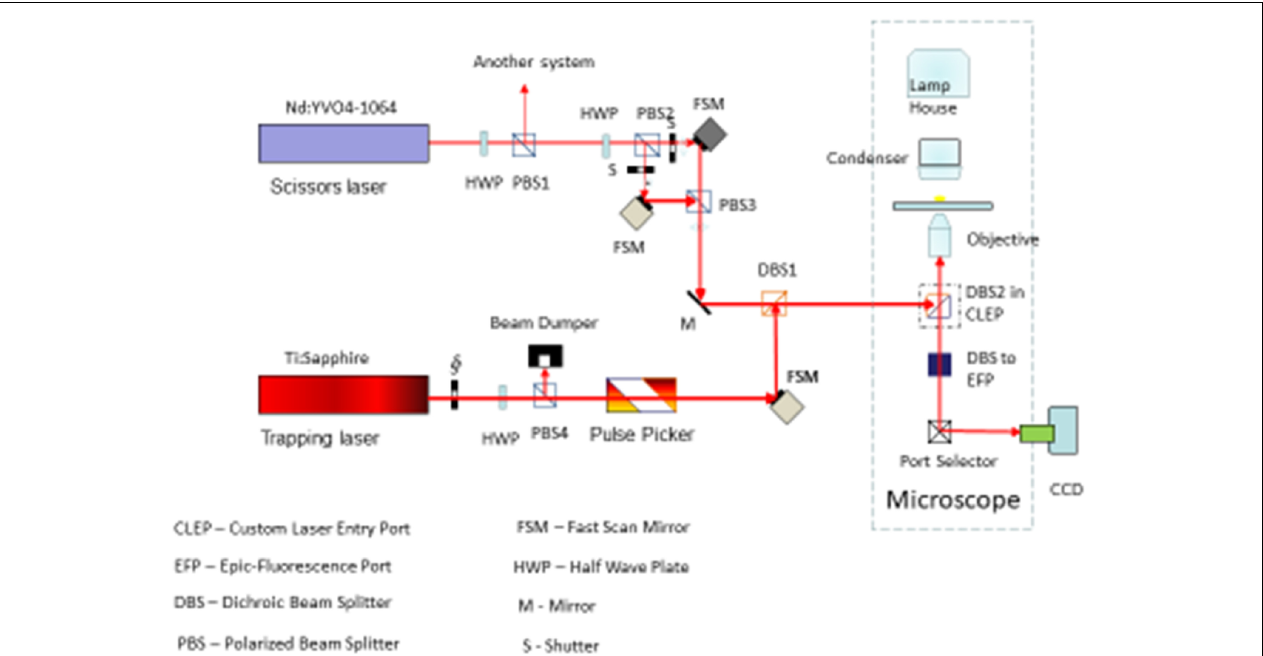
FIGURE 8 | Combined laser scissors and trapping microscope. The trapping laser is a CW NdYag (1.06 µ m) laser attenuted via a motor-driven rotatational half-wave plate. The beam is split by a beam-splitting polarizer into two trapping beams each controled by two fast scanning mirrors. This allows for two separately control trapping beams in the optical field. The ablation/cutting beam is a femtosecond Titanium sapphire laser tunable from 710 to 950 nm. The beam is attenuated by a half-wave plate and directed off a mirror and then off a fast scanning mirror. The beam is combined in the optical path with the trapping laser beam(s) thus allowing for separate control of either of the two trapping laser beams and the nano-ablation Titanium sapphire beam. Appropriate filter sets allow for reflection of one or more fluorescent wavelegth images of the cell into a cooled Hamamatsu ORCA CCD